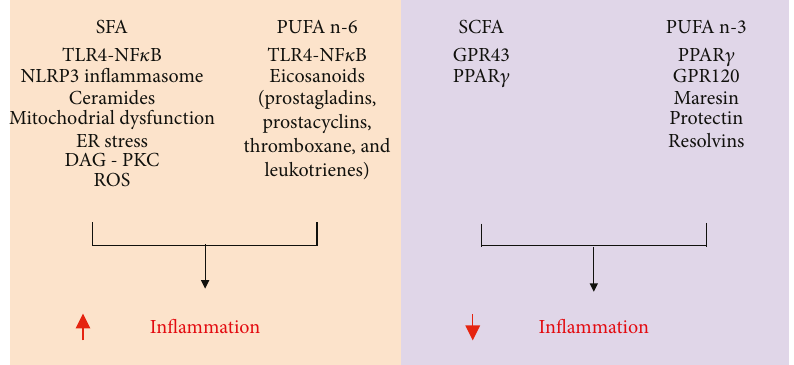
Figure 5: General overview of the mechanisms by which di ff erent fatty acids modulate in fl ammation. AMPK: AMP-activated protein kinase; DAG: diacylglycerol; ER: endoplasmic reticulum; GPR: G protein-coupled receptor; PKC: protein kinase C; PPAR: peroxisome proliferator- activated receptor; PUFA n-6: polyunsaturated n-6 fatty acids; PUFA n-3: polyunsaturated n-3 fatty acids; ROS: reactive oxygen species; SCFA: short-chain fatty acids; SFA: saturated fatty acids; TLR: toll-like